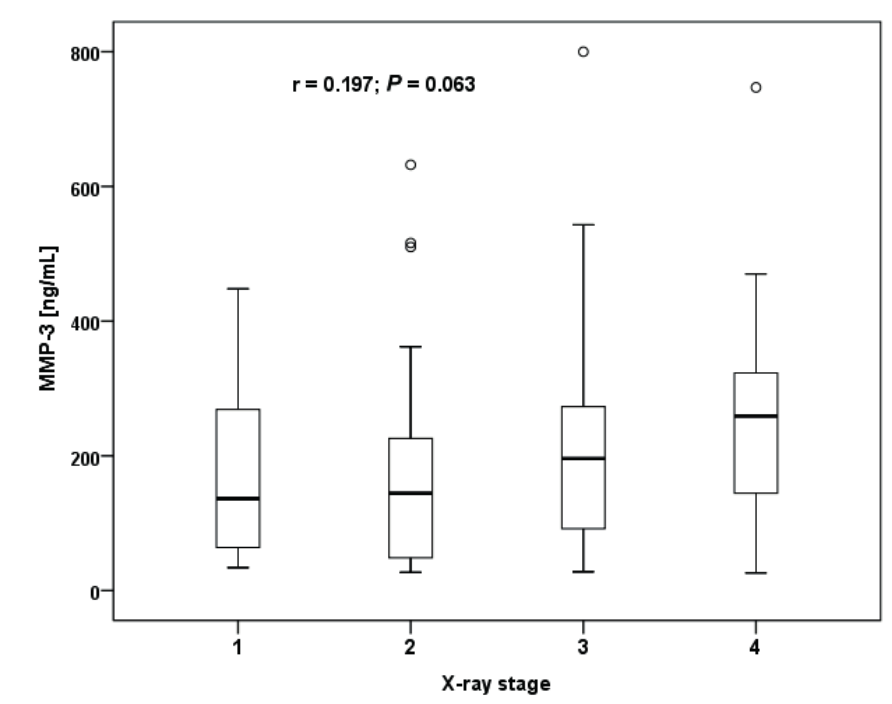
Fig. 7. Correlation between MMP-3 and radiographic stage. Box shows the distance be- tween the quartiles, with the median as a line, and the whiskers show minimum and maxi- mum values of MMP3. Outliers are shown as separate